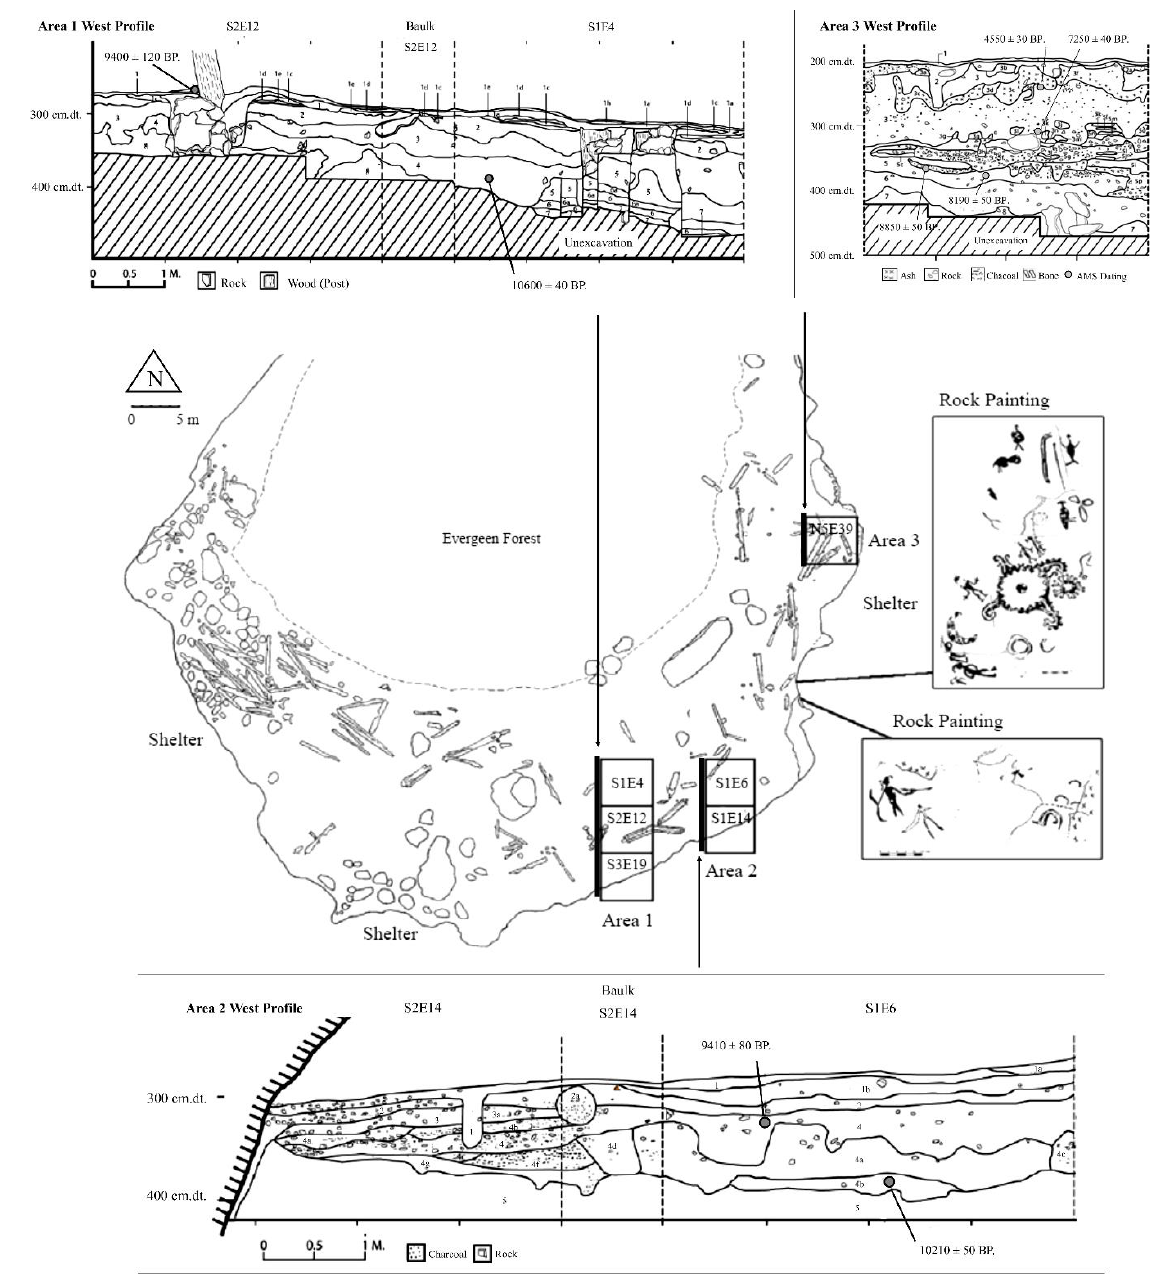
Figure 4. Ban Rai Rockshelter, showing the location of excavation units, radiocarbon determinations, and the west wall profiles from each area (Area 1, 2, and 3) (drawn by Pipad Krajaejun). Excavations recovered 11,600 lithic items (including 801 items from Area 1, 999 items from Area 2, and 9800 items from Area 3). These stone artifacts included sumatraliths, short axes, wasted cores and flakes, and utilized cores and flakes: they represented a stone tool assemblage, with hunter-gatherers exploiting material far distant from Ban Rai, within patchy and diverse ecological resource zones [7,9,32].